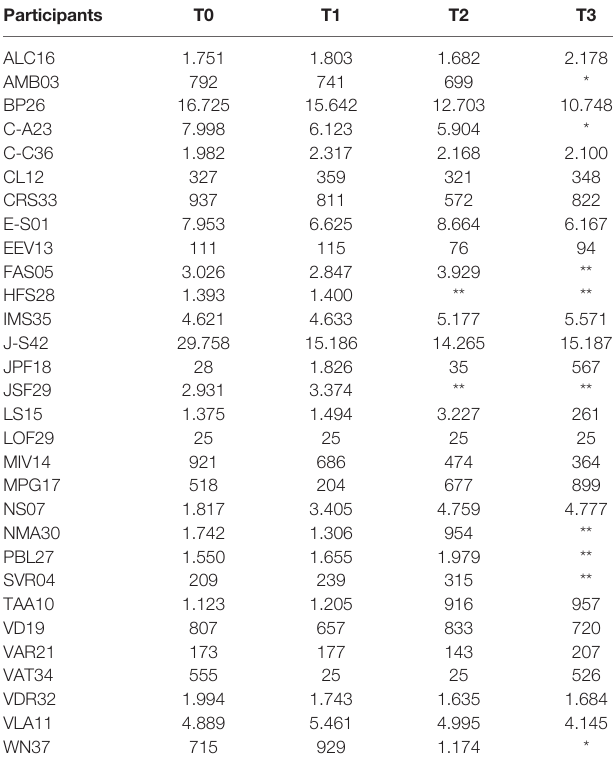
TABLE 8 | Evaluation of the plasma concentration of Immunoglobulin E (IgE) in mg/dL of 30 participants # at T0, T1,T2, and T3.